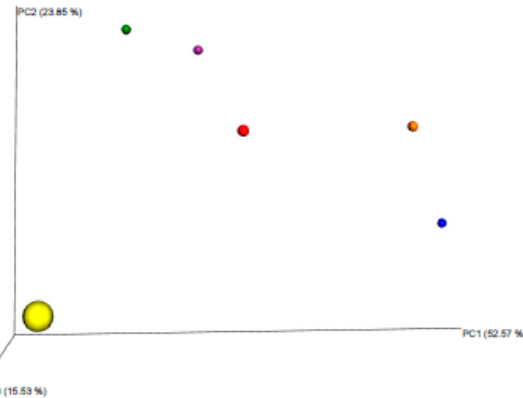
Figure 1. Family β -diversity using Bray-Curtis dissimilarity analysis of the first six-sample batch. There is a group of five samples in the upper-right area of the graph, while one sample is isolated on the down-left corner. The highlighted dot corresponds to T equigenitalis positive sample. Significant differences were found between the Taylorella equigenitalis carrier composition and the rest of samples ( p < 0.1). Table 1. Bray-Curtis dissimilarity indexes for the first batch.